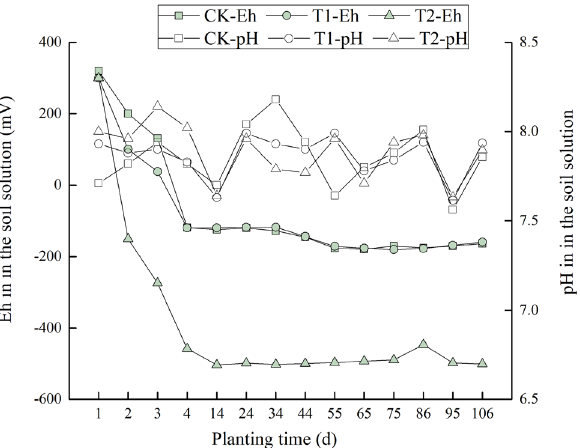
Figure 1. Changes in soil Eh and pH among different treatments. Treatments: no azolla (CK), azolla culturing in the water layer and intercropping with rice (T1), azolla incorporated into soil before rice transplantation (T2).